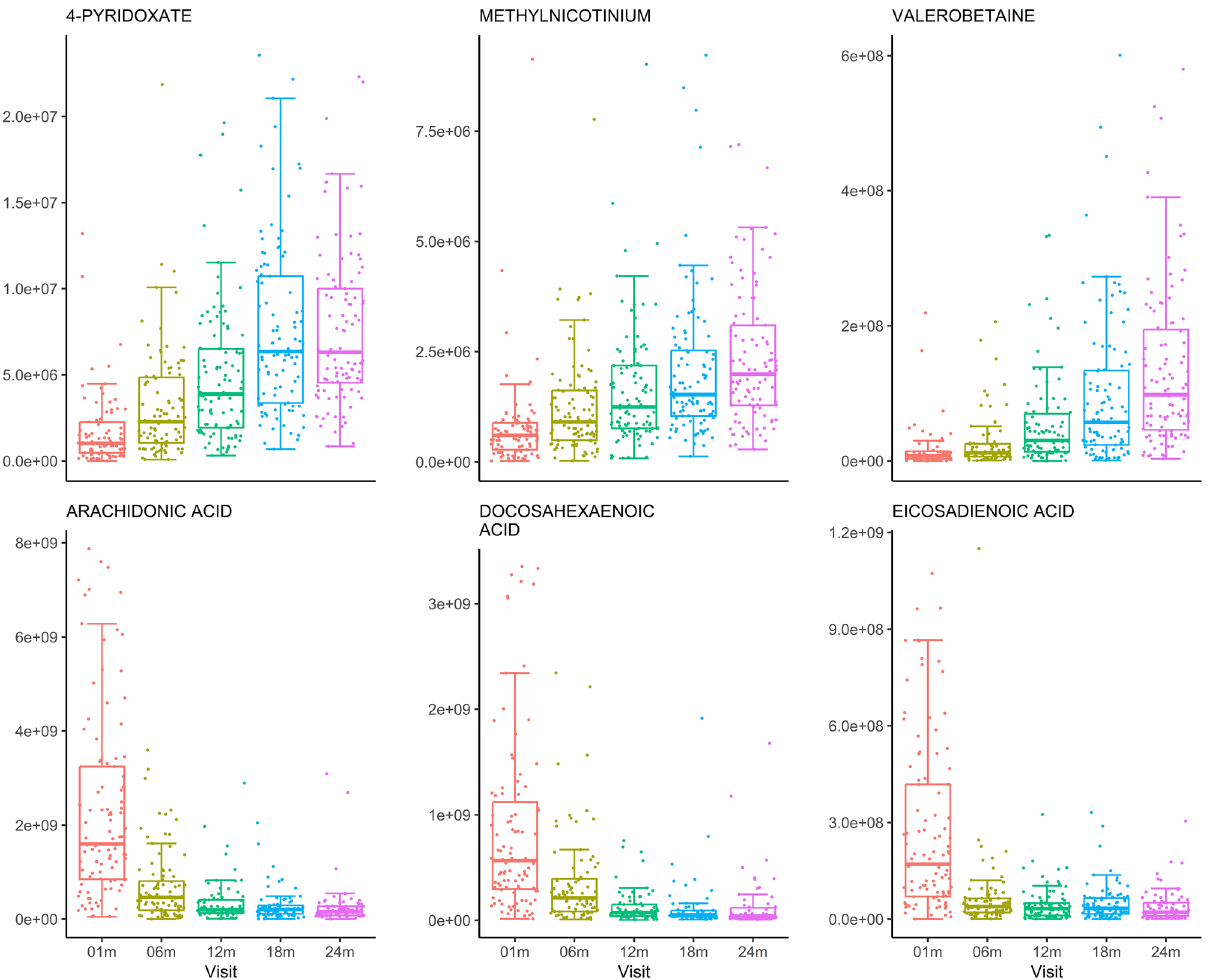
Figure 5. Visual representation of the intensity of selected confirmed metabolites detected in the HILIC (top) and C18 (bottom) chromatography columns which varied most significantly with infant age. Observations are grouped by visit, with the age in days corresponding with each visit as follows: 01 m (25–46), 06 m (164– 219), 12 m (351–429), 18 m (517–582), and 24 m (709–916). The metabolite labeled methylnicotinium was unidentified but was an accurate mass match for